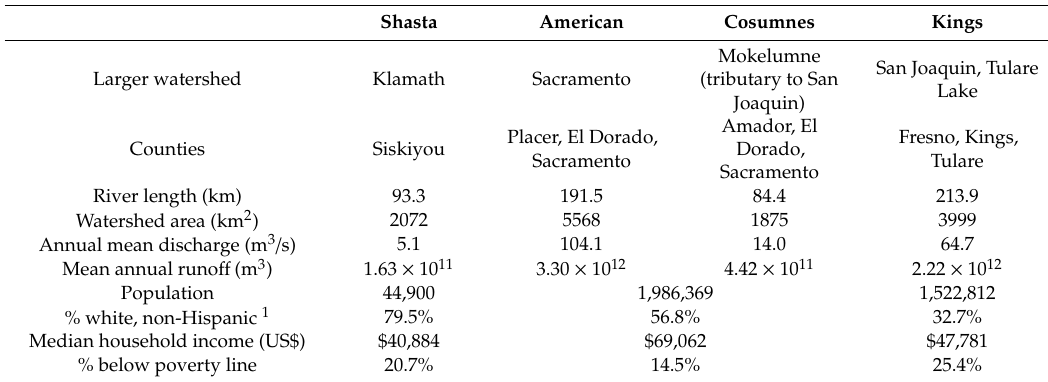
Figure 1. Map of the case study watersheds. Table 1. Watershed characteristics.